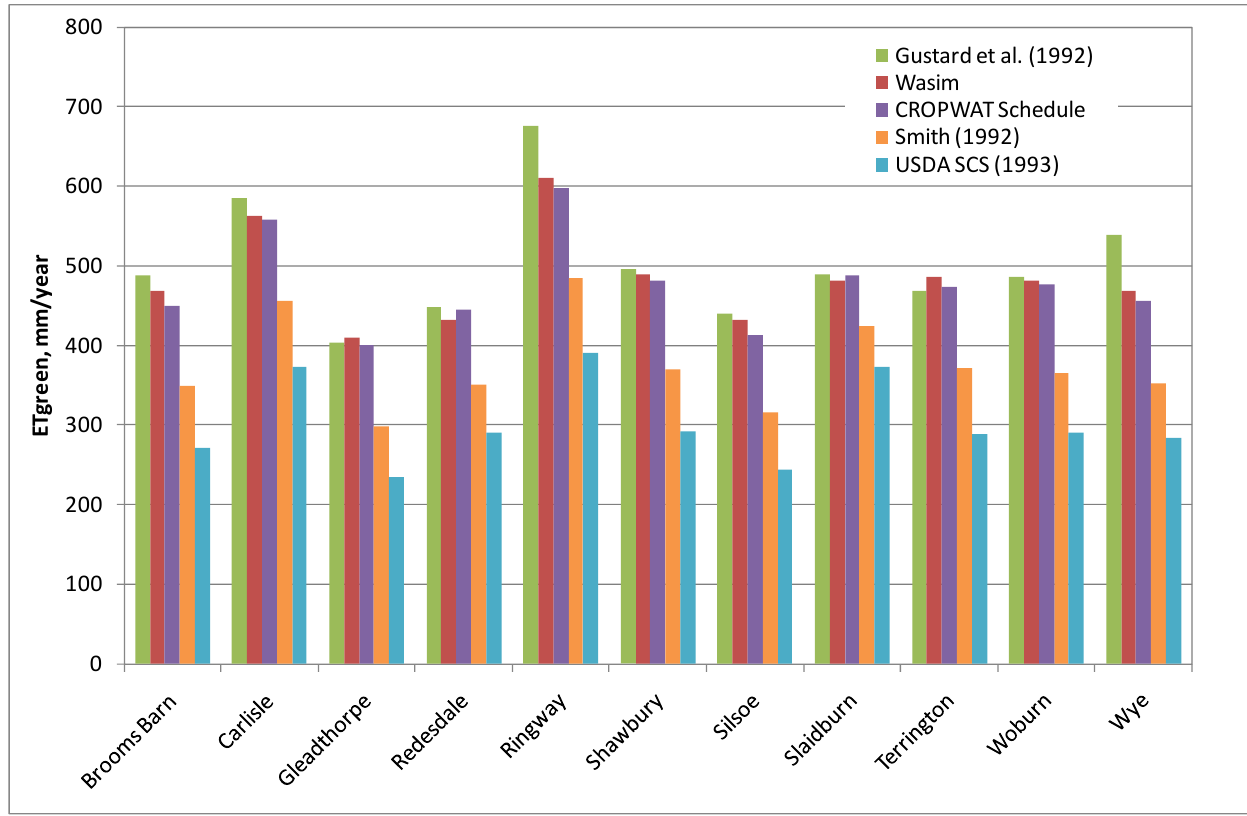
Figure 3. Average annual evapotranspiration, ET stations in England compared to estimated catchment-scale